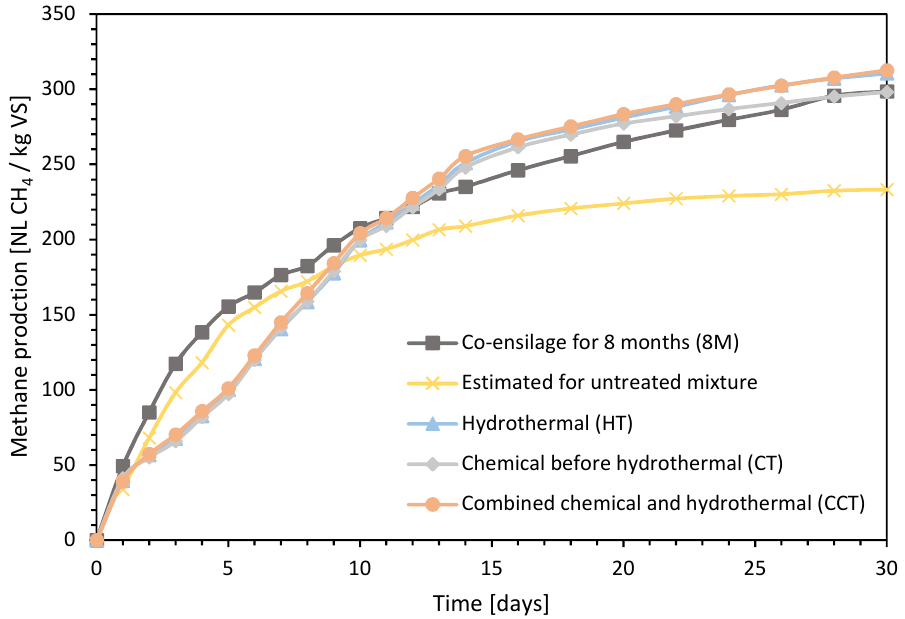
Figure 5. Cumulative methane yields of the co-ensiled sugar beet root and straw (80:20), hydrothermal- (HT), chemical- before hydrothermal- (CT), combined chemical- and hydrothermal- (CCT) pre-treated straw. Additionally, as a reference of the effect, the estimated biochemical methane potential (BMP) of the co-ensiling mixture, based on the BMP in the pure un-ensiled biomasses, was also added.